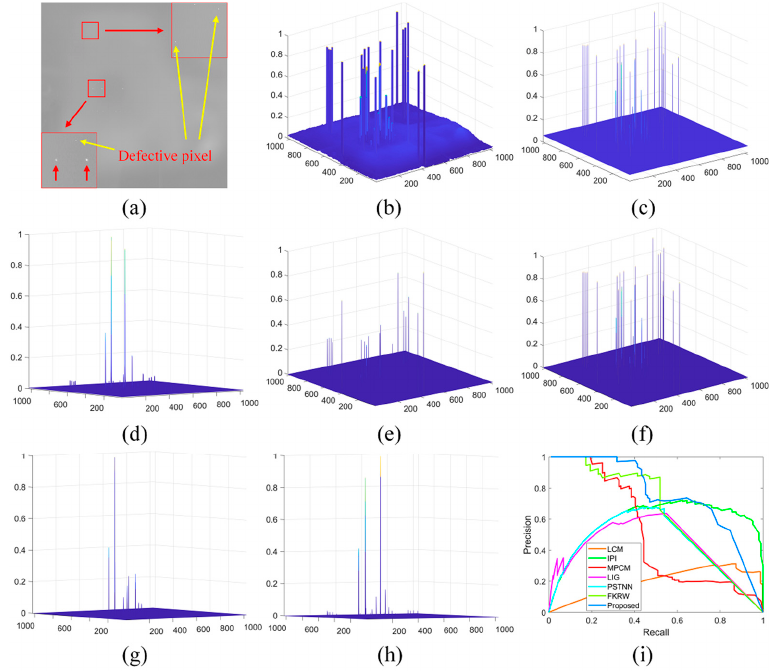
Figure 9. The performance comparison of different methods on single-pixel image with defective pixels: ( a ) target image; ( b – h ) normalized 3-D mesh obtained by the LCM [18], IPI [10], MCPM [19], LIG [22], PSTNN [12], FKRW [15], and the proposed method; and ( i ) PRC comparison.